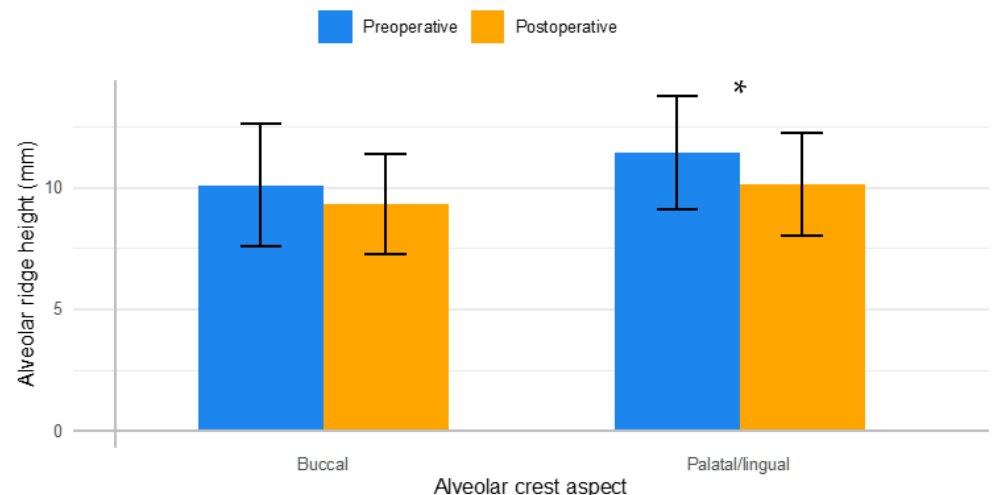
Figure 3. Alveolar ridge height measurements. Mean preoperative (blue) and postoperative (orange) crestal height measurements are shown for both the buccal and palatal/lingual aspects of the alveolar crest. * Statistically significant mean difference ( p < 0.05).